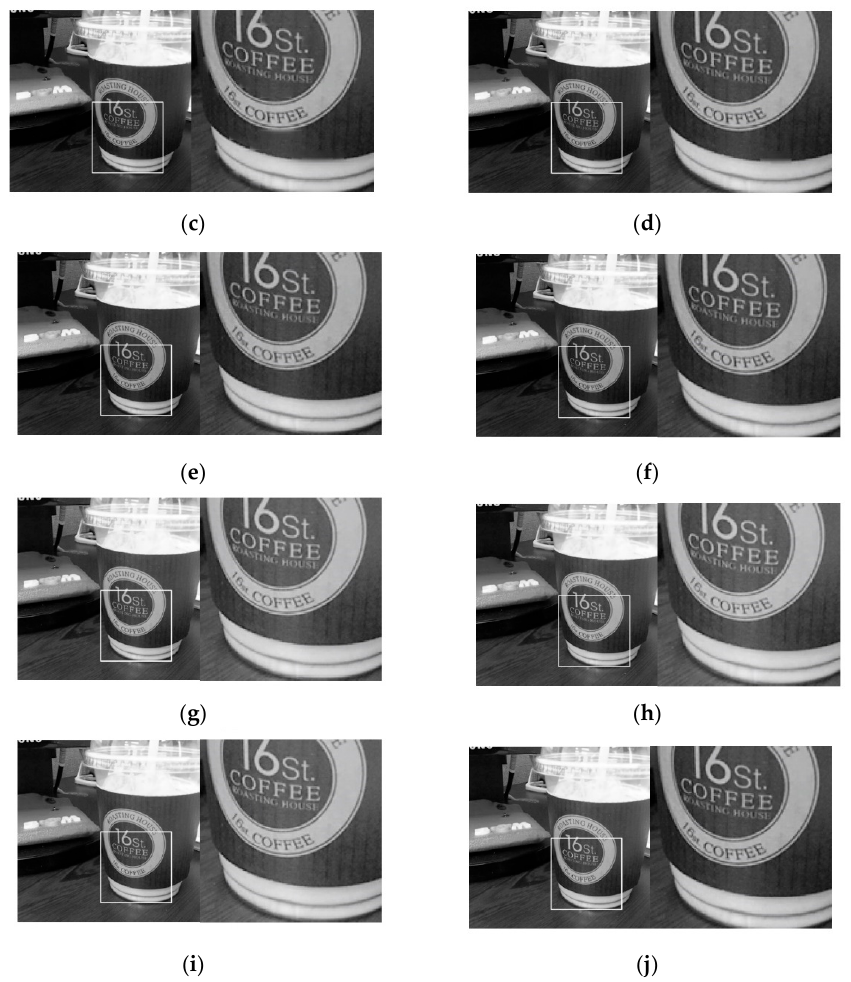
Figure 17. The expanded image ‘Cup’ image results: ( a ) Light Field Software, ( b ) SML, ( c ) DCT-STD, ( d ) DCT-VAR-CV, ( e ) SML-WHV, ( f ) Agarwala’s method, ( g ) DCT-Sharp-CV, ( h ) DCT-CORR-CV, ( i ) DCT-SVD-CV, ( j ) The Proposed Method.